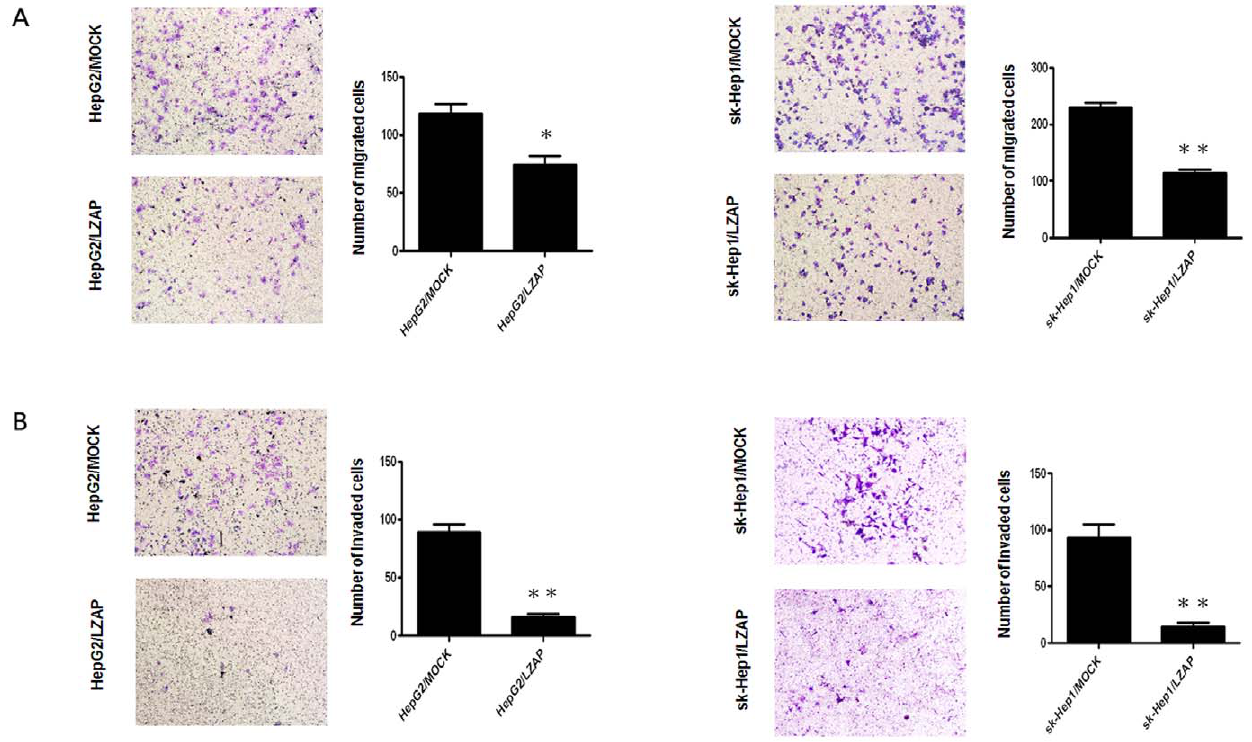
Figure 6. Transwell migration assays and Matrigel invasion assays of HepG2 and sk-Hep1 cells infected with Ad-LZAP and Ad- control. Images are shown on the left (magnification: 100 6 ), and the quantification of 10 randomly selected fields is shown on the right. The values shown are expressed as the mean 6 SD of three independent experiments. The p values were calculated using Student’s t-test. ( A ) LZAP inhibited cell migration in the HepG2 and sk-Hep1 cells. ( B ) LZAP also significantly inhibited cell invasion by the HepG2 and sk-Hep1 cells. *p , 0.05 versus Ad- control; ** , 0.01 versus Ad-control.